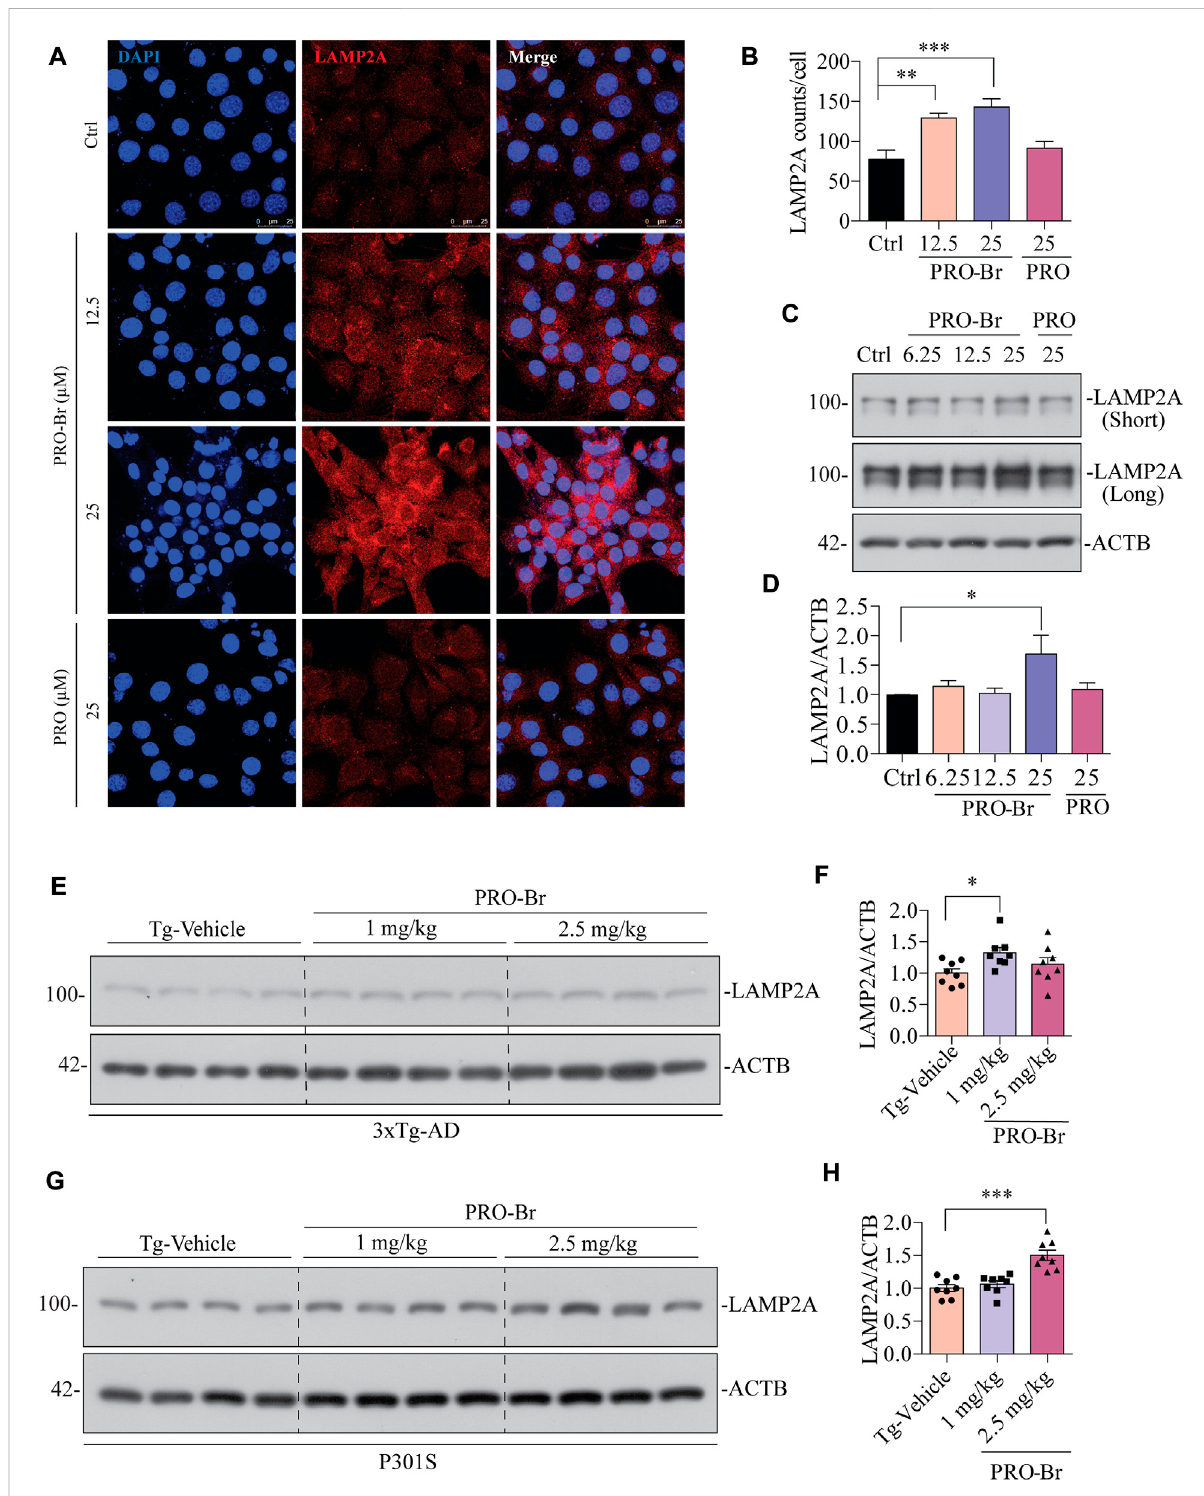
FIGURE 7 PRO-Br increased chaperone-mediated autophagy markers in vitro and in vivo (A-B) immunostaining, and (C-D) immunoblotting results show that PRO-Br treatment dose-dependently increases LAMP2A in HT22 cells. LAMP2A is shownin red and DAPI is shown in blue. Data are represented as mean ± SEM of three replicates. PRO-Br-mediated increase in expression of LAMP2A in (E-F) 3xTg-AD and (G-H) P301S mice models. Data quanti fi cation was performed by ImageJ software, * p < 0.05 and *** p < 0.001 vs. Tg-Vehicle (one-way